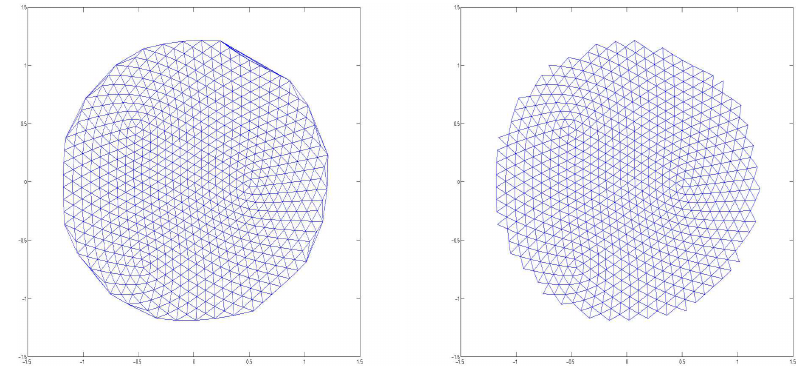
Fig. 1. A local Delaunay triangulation T k (left) and the triangulation b T k after the deletion of triangles that are not guaranteed to satisfy the Delaunay property globally.